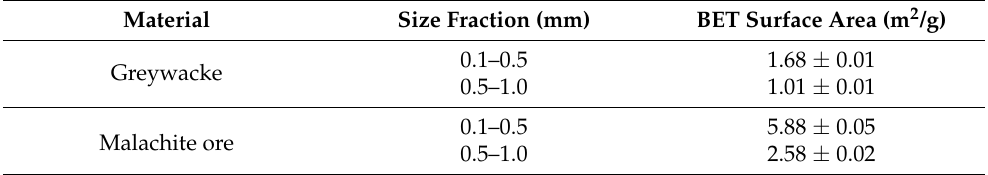
Table 1. BET analysis results for greywacke and malachite ore.